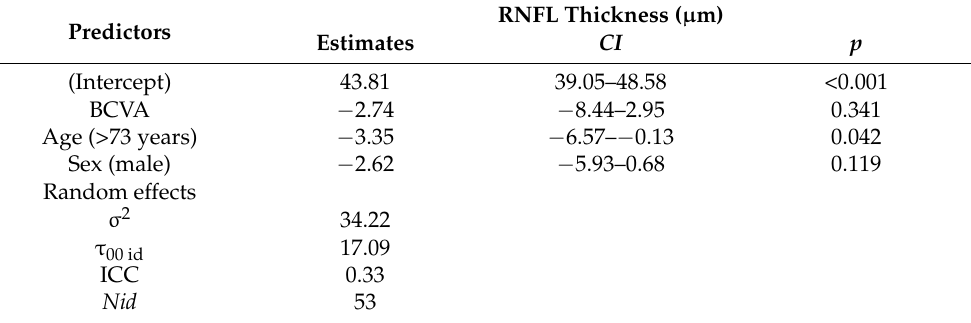
Table 3. Results of fitting model 3.